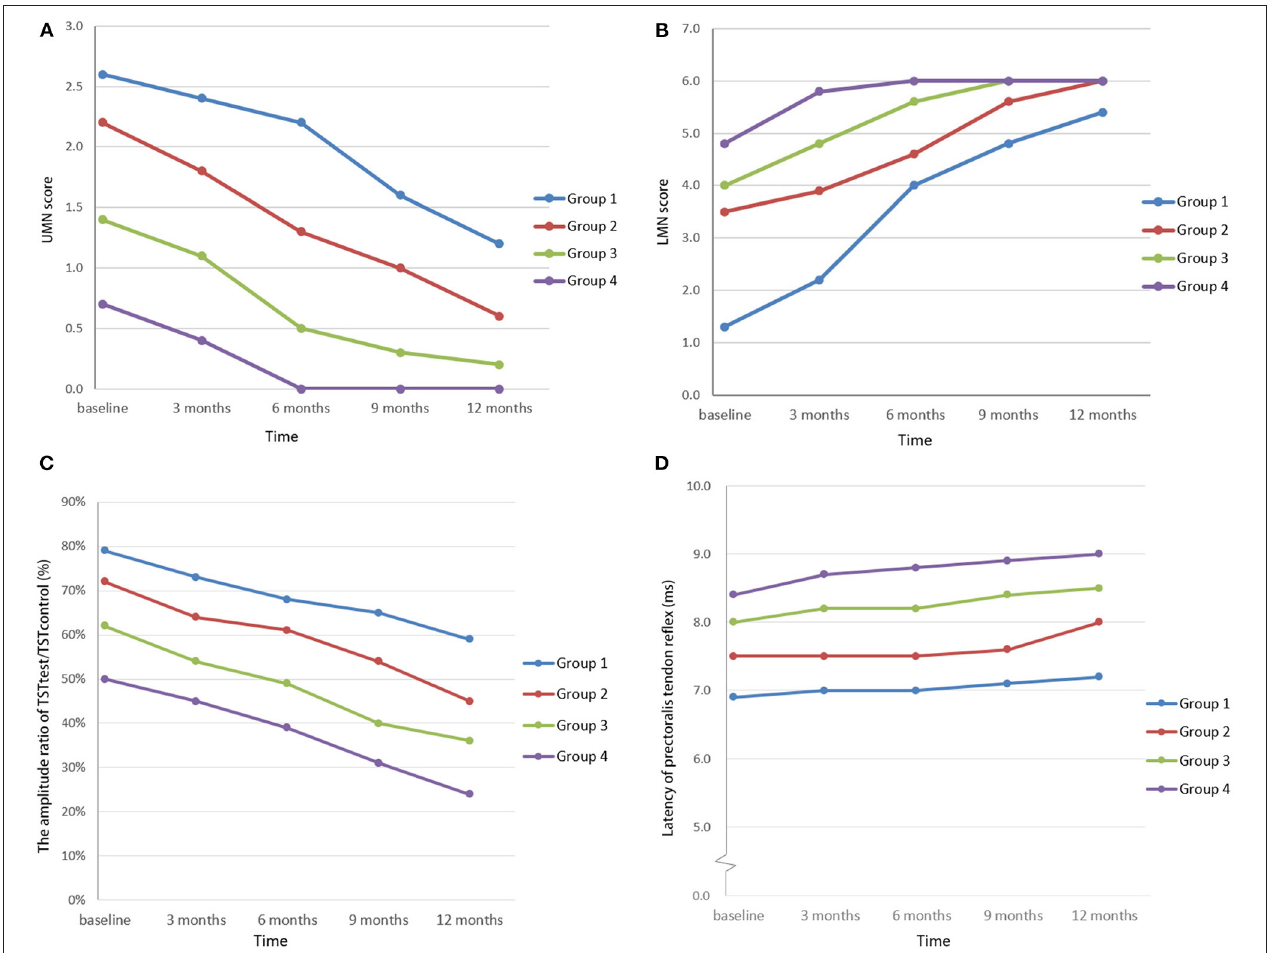
FIGURE 3 | UMN scores of the cervical region (A) , LMN scores of the cervical region (B) , TST test /TST control amplitude ratios (C) , and latencies of quantitative detection of the pectoralis tendon reflex (D) among FAS patients in the study. In the follow-up study, the UMN score and the TST test /TST control amplitude ratio decreased, in contrast to the increased LMN score, while the latency of quantitative detection of the pectoralis tendon reflex remained almost unchanged. (Patients were divided into four groups according to the length of the disease course: group 1: disease duration < 6 months; group 2: disease duration 6–12 months; group 3: disease duration 12–24 months; and group 4: disease duration > 24